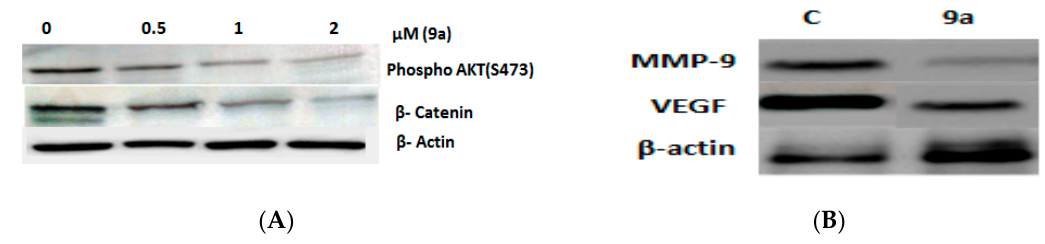
Figure 6. Compound 9a downregulated metastatic-related genes. ( A ) Compound 9a down-regulated phosphoAkt and β catenin. Cells were treated with 0.5, 1 and 2 μ M of 9a for 24 h. The cell lysates were collected and the expression of phospho Akt and β catenin was studied by western blot analysis using specific antibodies in treated and non-treated control cells. β -actin was used as a loading control; ( B ) Compound 9a down-regulated MMP 9 and VEGF. Cells were treated with 2 μ M of 9a for 24 h. The cell lysates were collected and the expression of MMP 9 and VEGF was studied by western blot analysis using specific antibodies in treated and non-treated control cells. β -actin was used as a loading control. C: control (untreated cells).